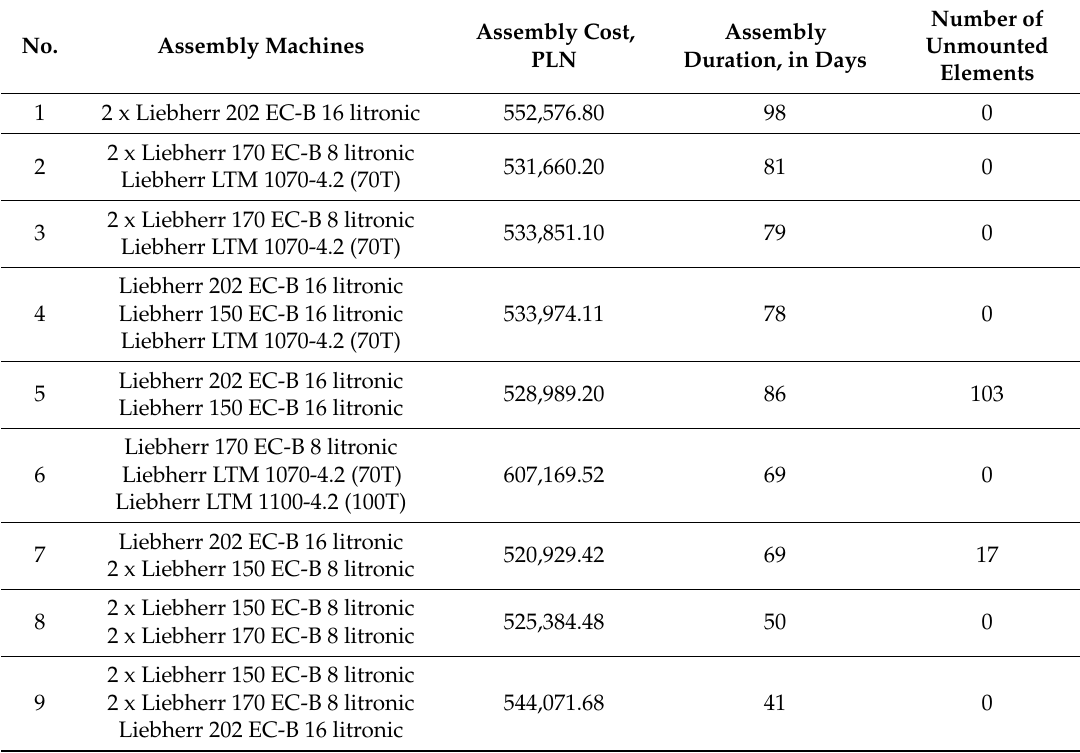
Table 3. The results of t computer simulations-description in the text. Sourced from our own study.